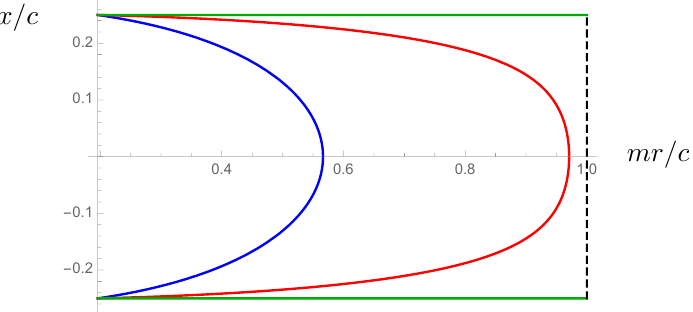
Figure 1 . Types of geodesic for J 2 = 1 = 2, J 1 = 1 = 5. The blue and red curves are the two possible connected geodesics and the pair of green lines is the disconnected geodesic. All three geodesics p end at mr UV =c = 1 = 26 and the dashed line is the IR cut-o(cid:11) mr IR =c =